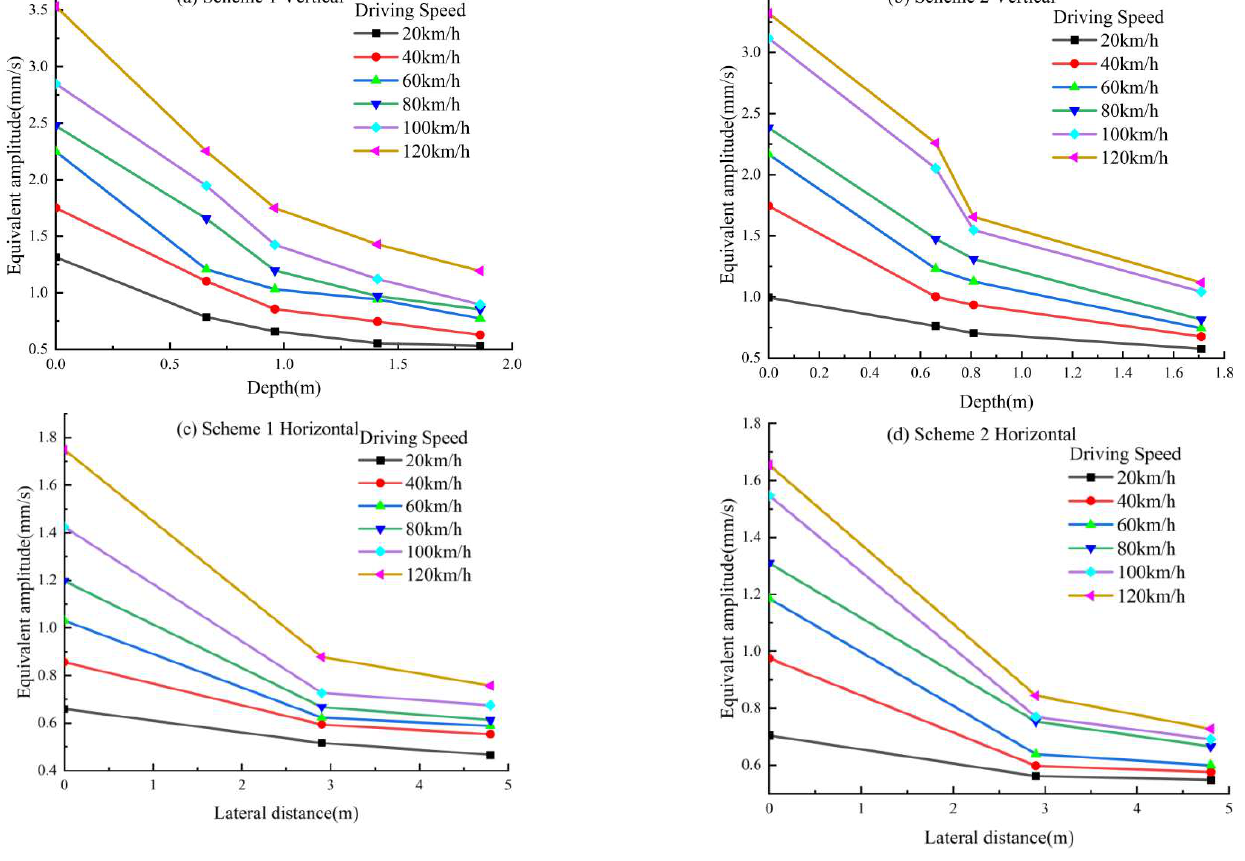
Figure 14. Equivalent amplitude decay curve.